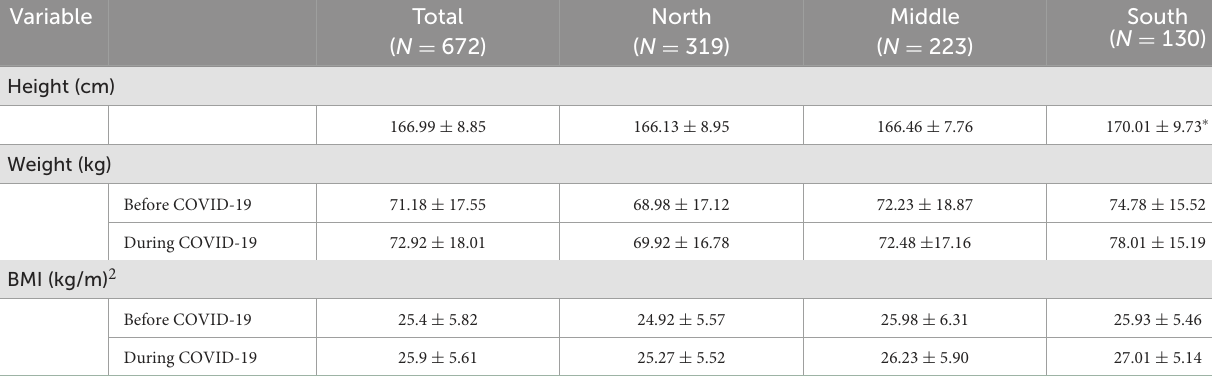
TABLE 3 Anthropometric measurement for participants according to the region.